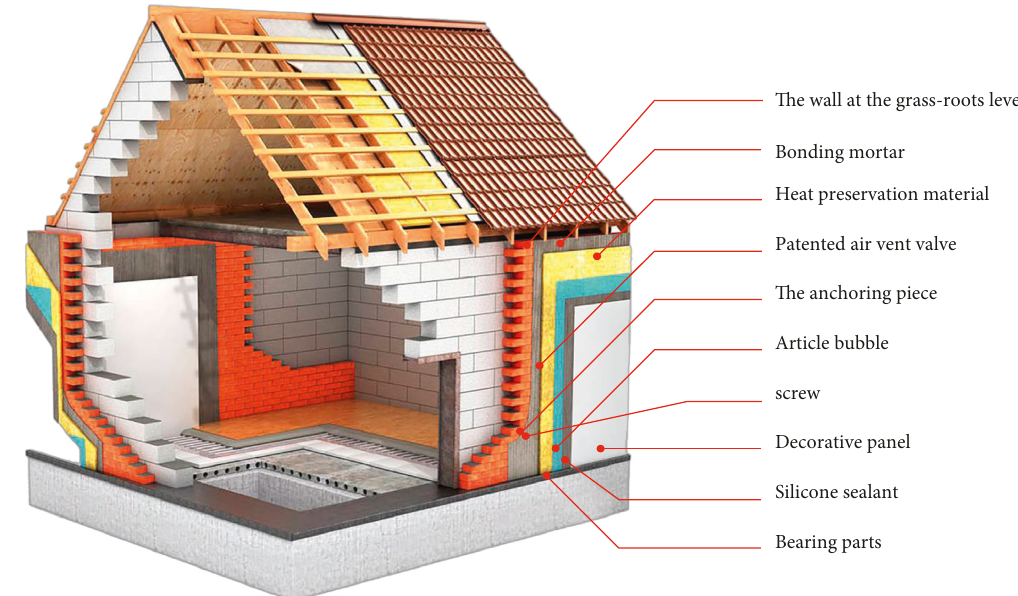
Figure 1: Composite thermal insulation